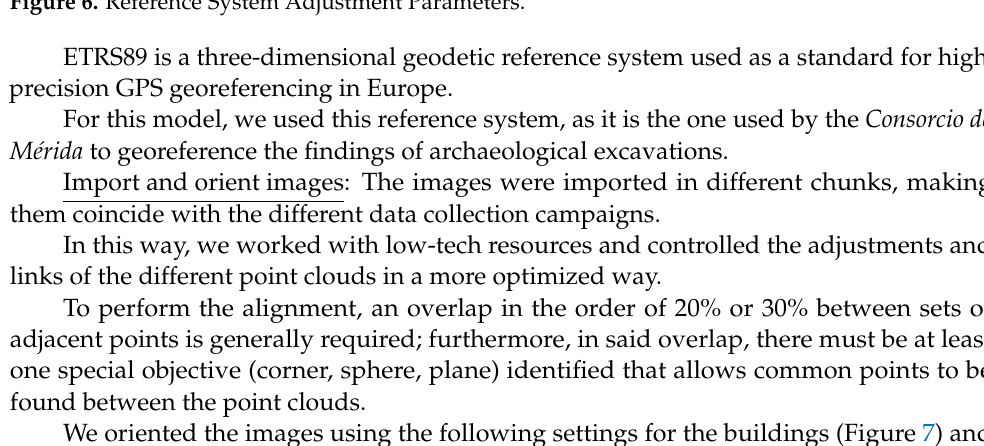
Figure 8. Photo Orientation Parameters of the topography. -